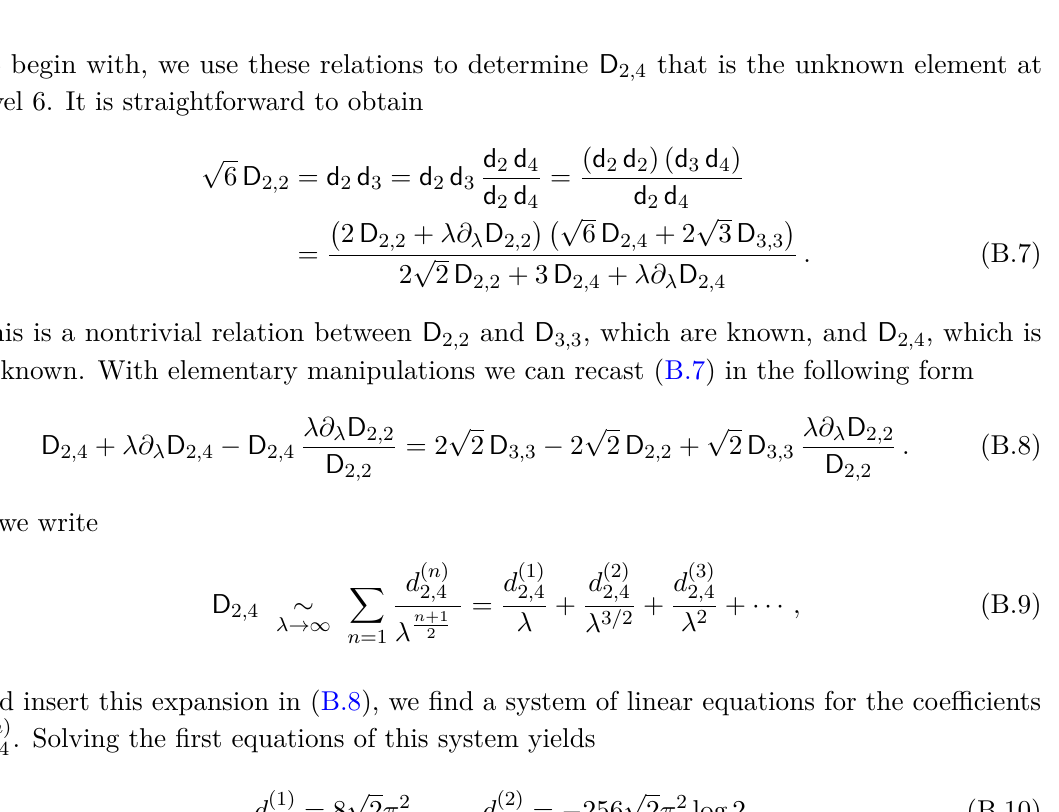
in the strong-coupling expansion of D 2 , 4 2 , 4